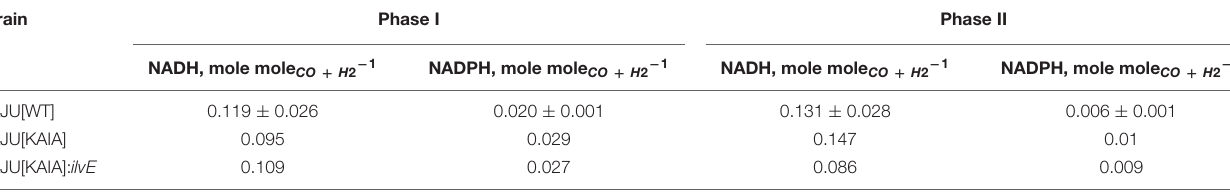
TABLE 4 | NADH and NADPH yields derived from flux balance analysis for the first (I) and second (II) growth phase considering the WLP and the Nfn reaction.